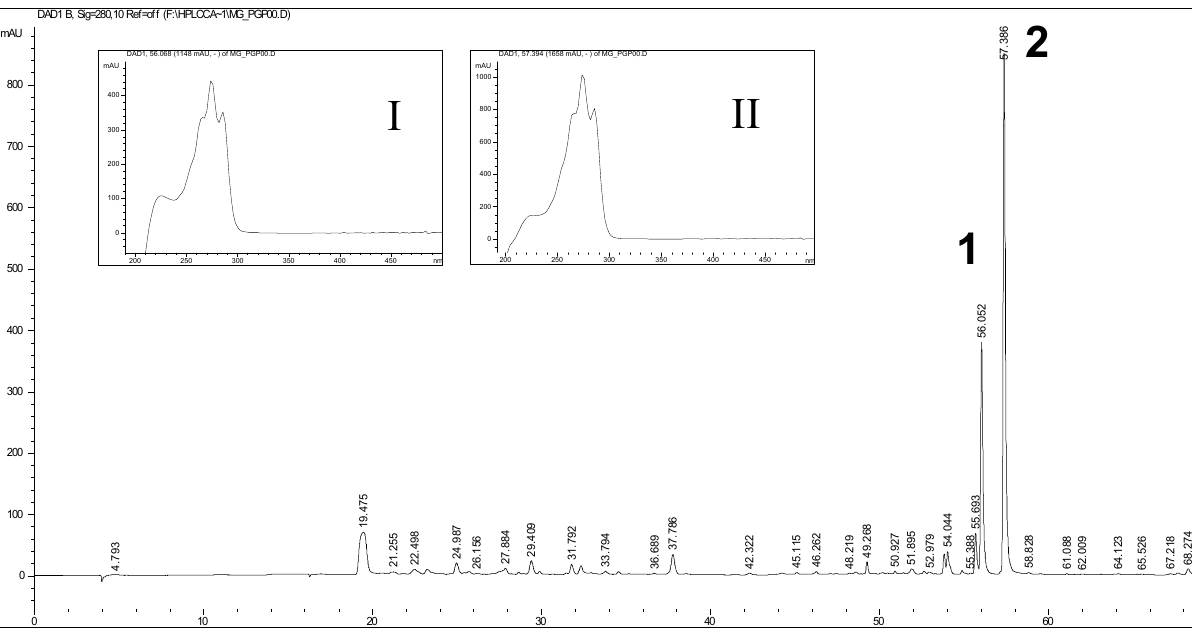
Figure 1. We show RP-HPLC-DAD separation of the polar extracts (80% methanol) from pomegranate oil. The chromatogram was performed at λ = 280 nm. Moreover we report in the insets I and II the UV-Vis spectra evaluated for the peaks no. 1 and 2 corresponding at = 56.1 min (no. 1) and t = 57.4 min (no. two specific retention times, t R R